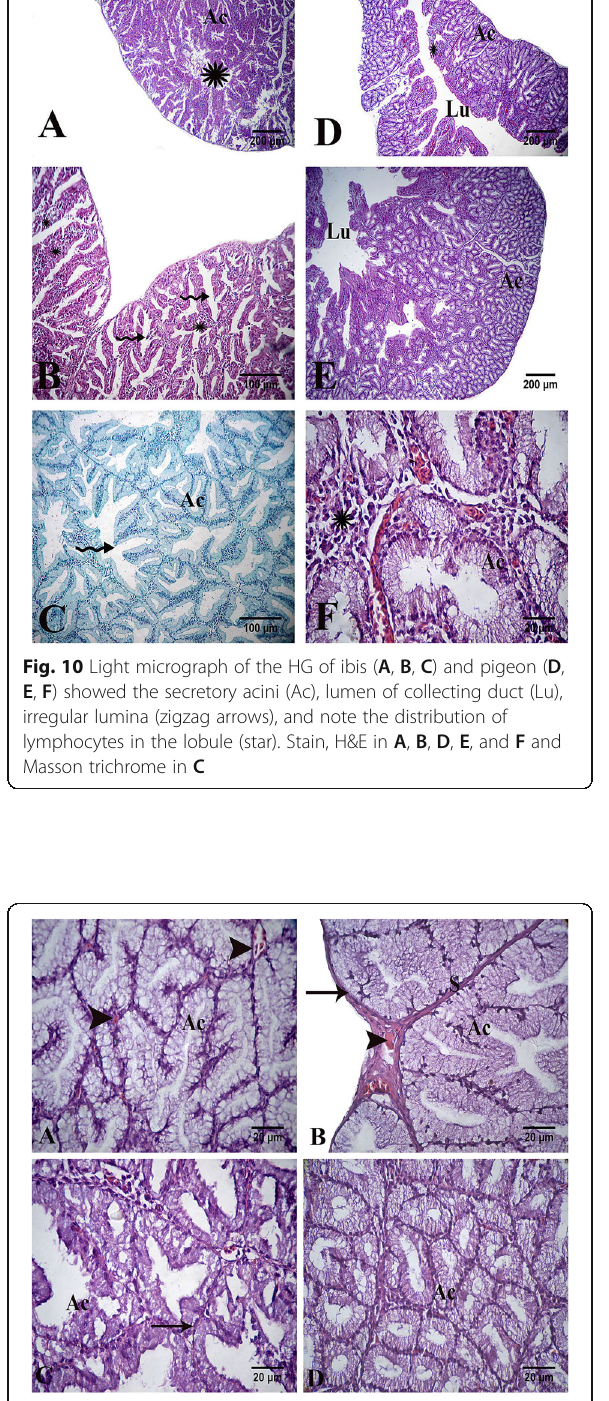
Fig. 11 Light micrograph of the HG of duck ( A ), goose ( B ), ibis ( C ), and pigeon ( D ). Secretory acini (Ac), capsule (arrow), blood vessel and capillaries in the capsule and in interstitial tissue (arrow heads), and myoepithelial cell (arrow). Stain,